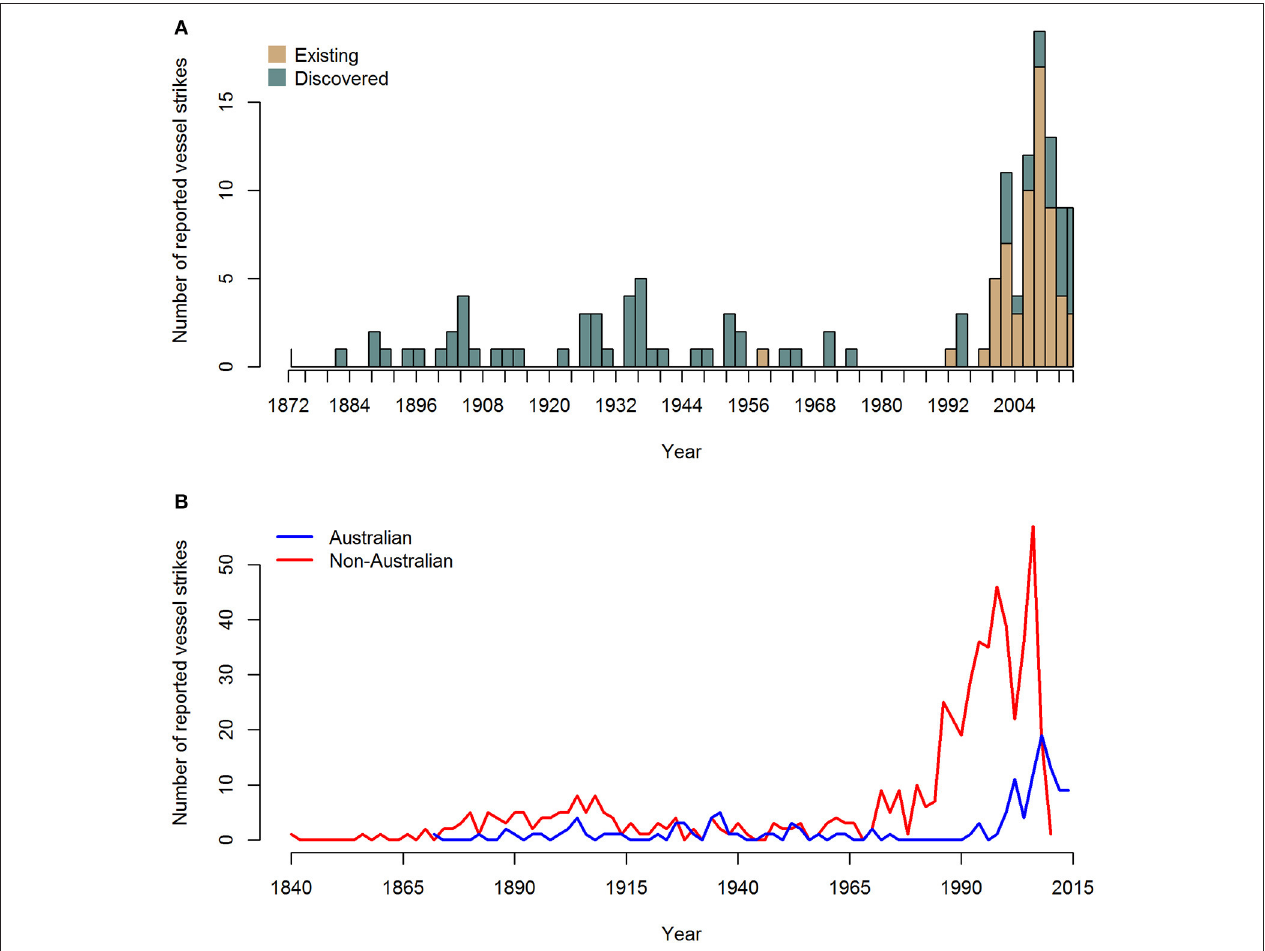
FIGURE 2 | (A) Temporal comparison of existing Australian vessel strike reports and new data. Data pooled into 2 year blocks. (B) Comparison of Australian and non-Australian records over time (based on IWC, 2010 data and our additional new worldwide records). Note that extra non-Australia records were not the focus of this study but were discovered incidentally when searching for Australian records.